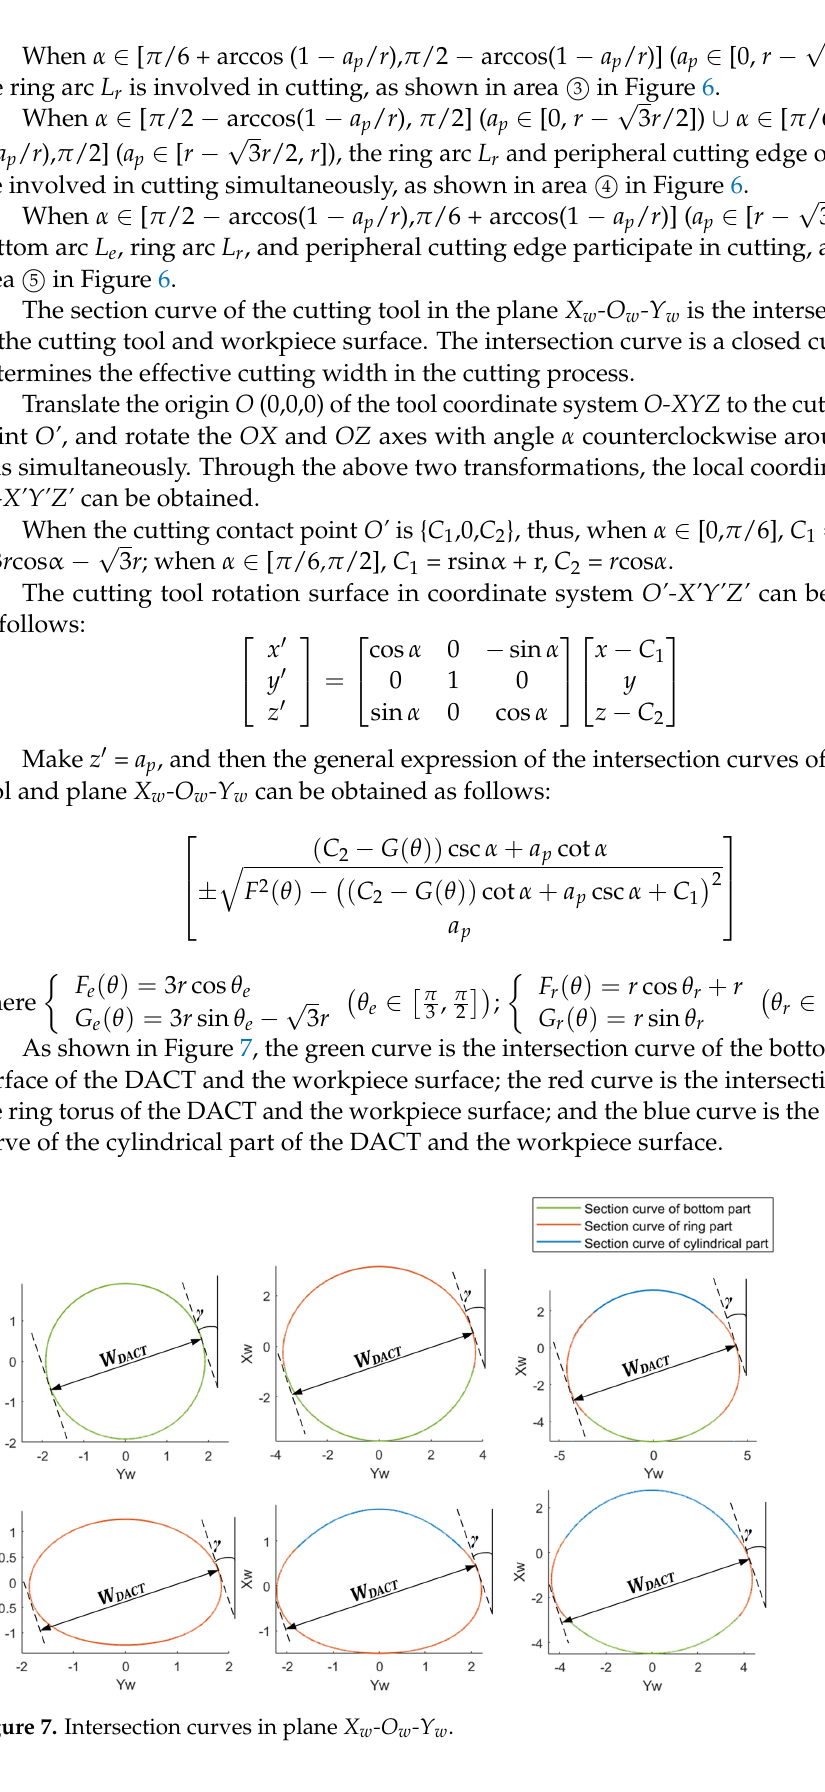
   . The intersection curves of the DACT in the normal section Y’-O’-Z’ are shown in Fig- ure 8.